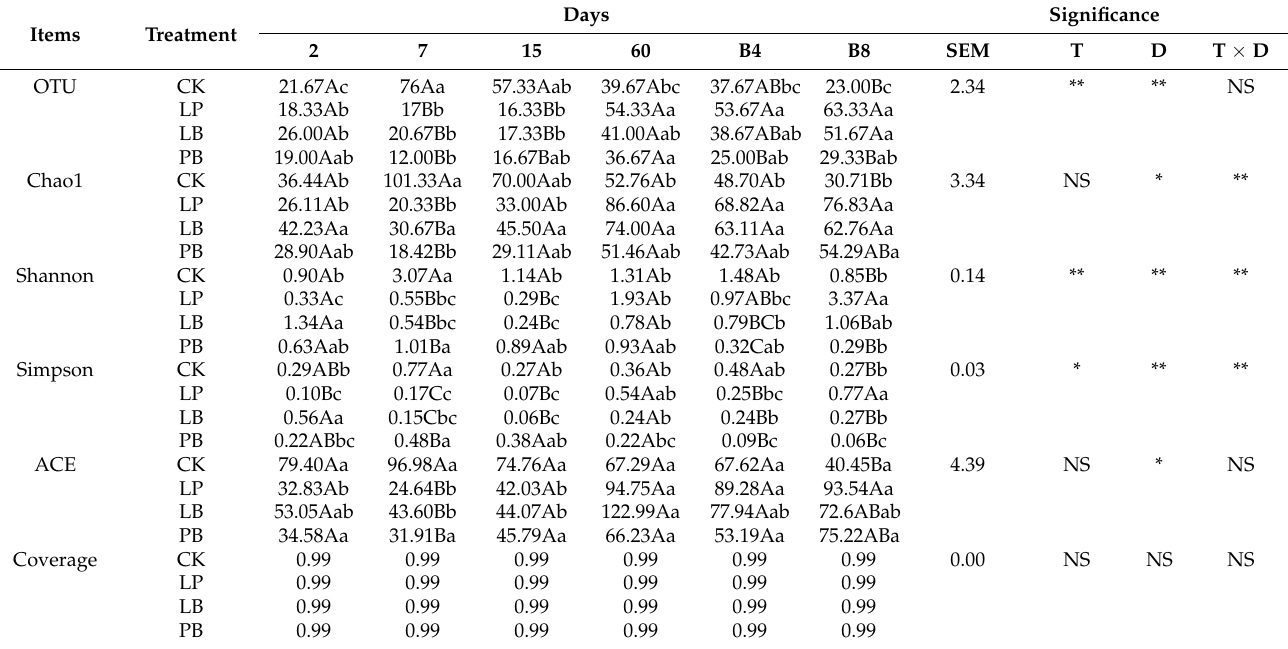
Table 5. Effects of additives and days of anaerobic fermentation and aerobic exposure on microbial alpha diversity of native grass